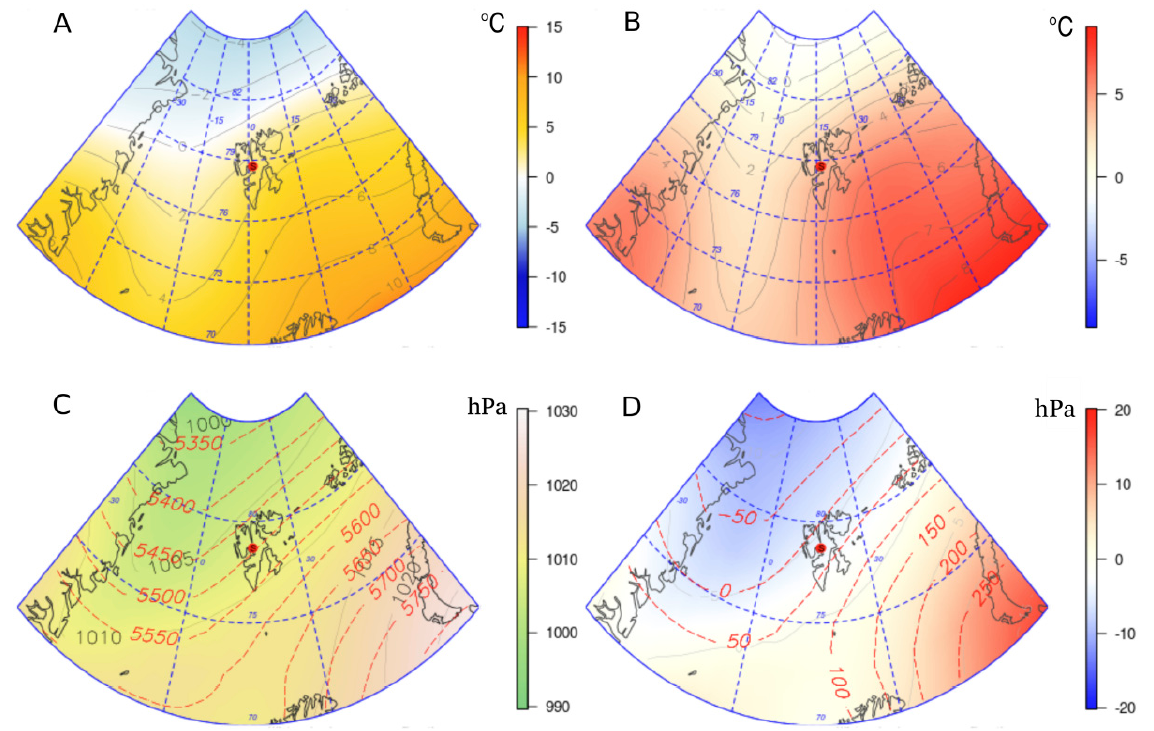
Figure 8. Air temperature at an altitude of 850 hPa (T850) (°C)—grey solid line ( A ) and its anomalies ( B ) and the average daily sea-level pressure distribution (SLP) (hPa)—grey solid line and geopotential height of 500 hPa (m)—red dotted line ( C ) and its anomalies ( D ) for 20 August 2016. The red point shows the research area.